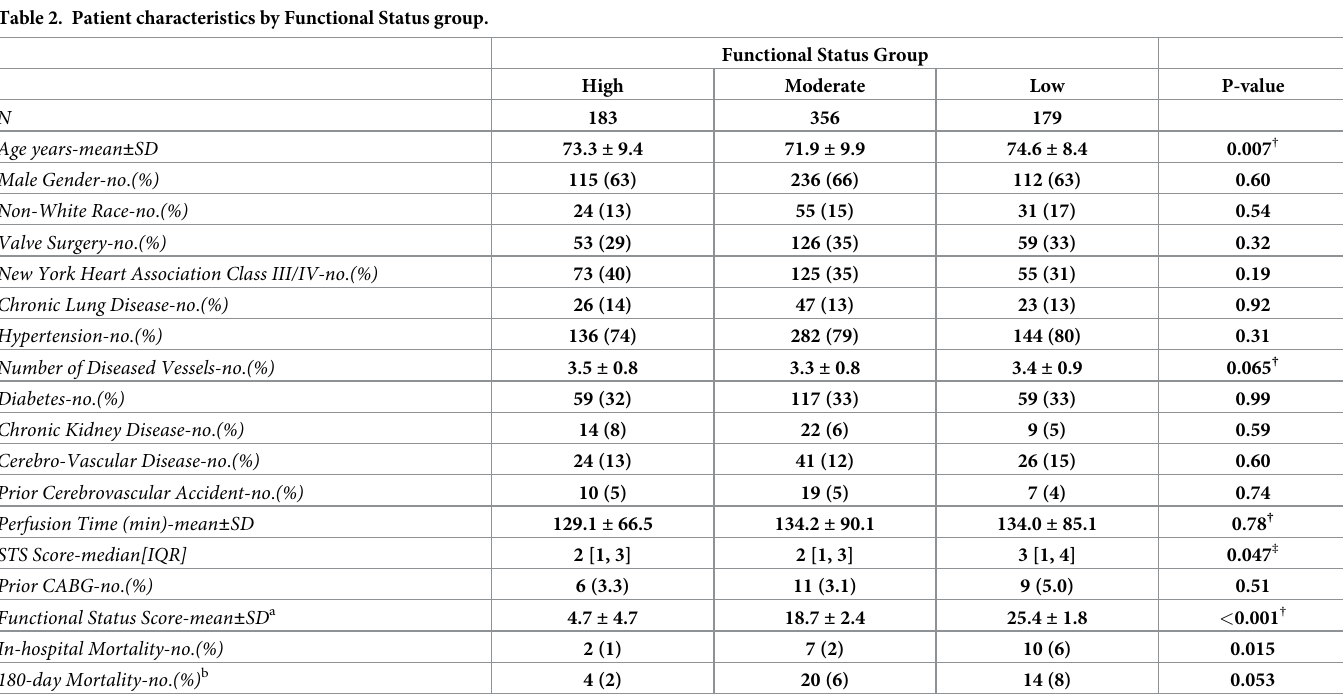
Table 2. Patient characteristics by Functional Status